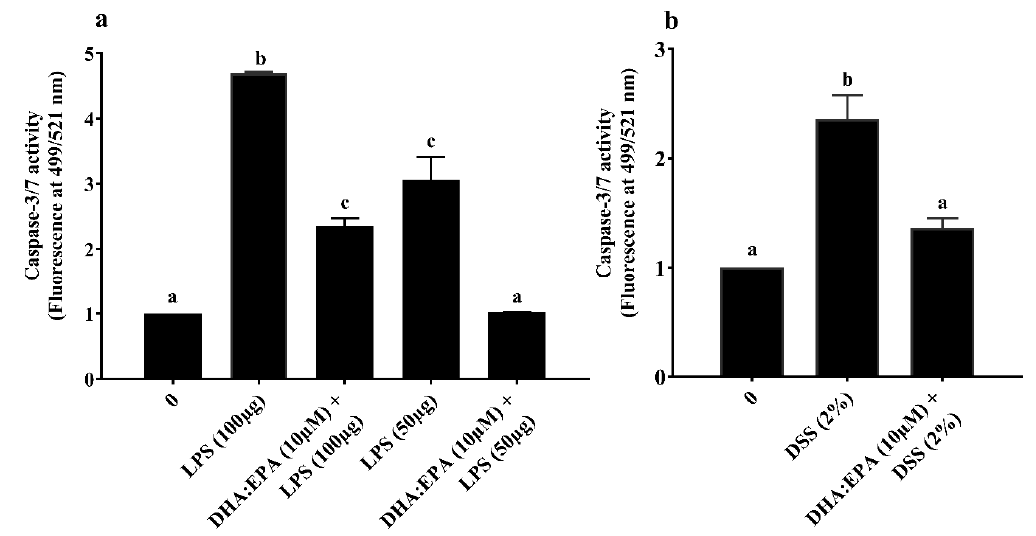
Figure 5. E ff ects of DHA:EPA (1:2; 10 µ M) pre-treatment (24 h) on the apoptosis of IPEC-J2 cells challenged by ( a ) LPS (50 or 100 µ g / mL) and ( b ) DSS (2%) for 24 h. Data are presented as mean ± SEM Figure 5. Effects of DHA:EPA (1:2; 10 μ M) pre-treatment (24 h) on the apoptosis of IPEC-J2 cells ( n = 3, one-way ANOVA). Statistically significant di ff erences among the treatments are denoted by challenged by ( a ) LPS (50 or 100 μ g/mL) and ( b ) DSS (2%) for 24 h. Data are presented as mean ± SEM di ff erent letters (a, b, c), where p < ( n = 3, one-way ANOVA). Statistically significant differences among the treatments are denoted by different letters (a, b, c), where p < 0.05.